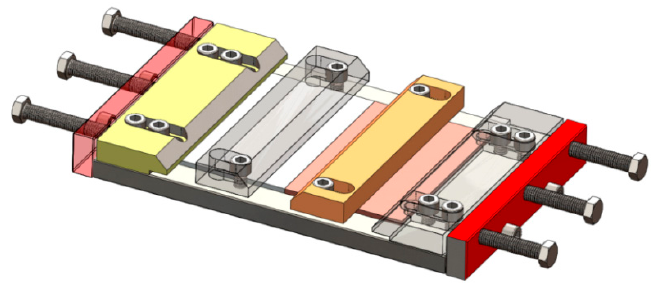
Figure 1. Schematic representation of the fixture.